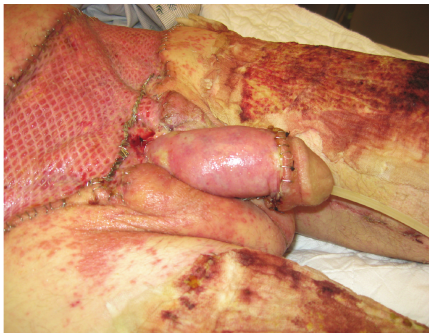
Figure 6: Healing of Fournier’s gangrene wounds: skin graft and donor sites one week after